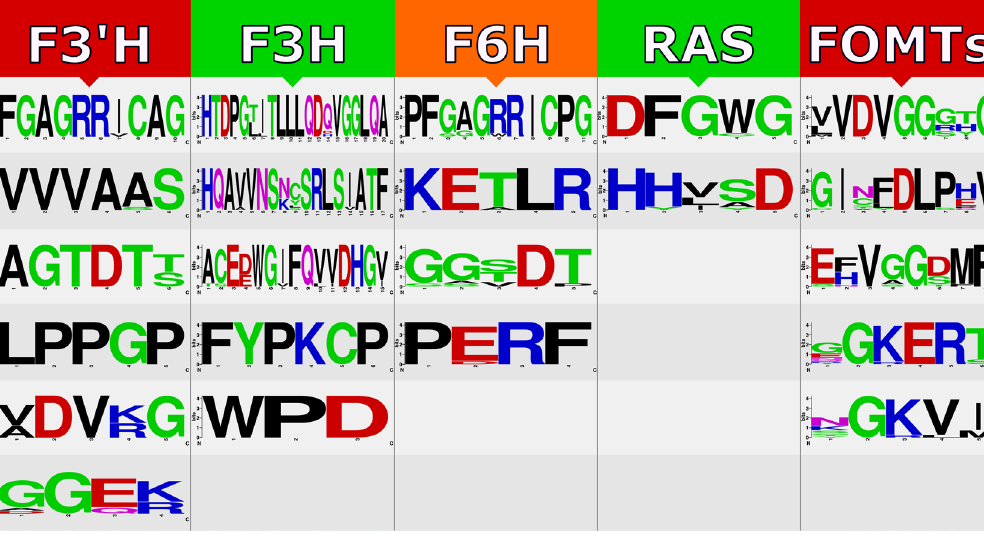
Figure 2. Represent of domains and motifs of FOMTs, F3H, F3 ʹ H, F6H, and RAS genes identified from D. kotschyi using Interpro database and literature data by webLogo